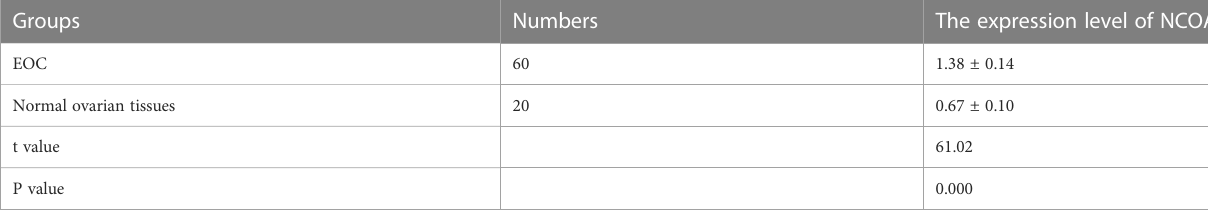
TABLE 1 Comparison of NCOA5 expression between EOC and normal ovarian tissues.